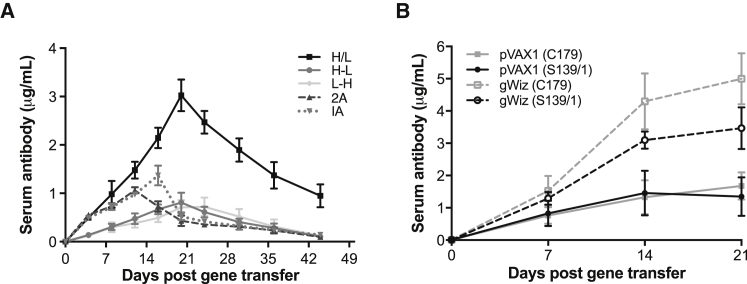
Optimized Gene Cassettes and Vector Backbone Enhance In Vivo mAb Expression(A) Comparison of 5A8 mAb expression over time with different pDNA (50 μg) gene configurations in the pVAX1 vector administered by EP in BALB/c mice (n = 5–8). Serum 5A8 concentrations were measured by CD4 binding ELISAs. (B) gWiz expression vector yields higher mAb concentrations than pVAX1. Following 20 U of hyaluronidase pretreatment, BALB/c mice (n = 3) were administered 10 μg of pVAX1 (solid lines) or gWiz (dashed lines) encoding H/L of C179 or S139/1. Serum mAb concentrations were measured by HA-specific binding ELISAs. Data are presented as mean ± SEM. H/L, separate plasmids carrying H and L chain genes under CMV promoter; H-L, single plasmid with H- and L-chain genes under CMV and human elongation factor-1 alpha (hEF1α) promoters, respectively; L-H, single plasmid with L- and H-chain genes under CMV and hEF1α promoters, respectively; 2A, single plasmid with H- and L-chain genes under CMV promoter separated by furin cleavage site coupled with a P2A self-processing peptide; IA, immunoadhesin.